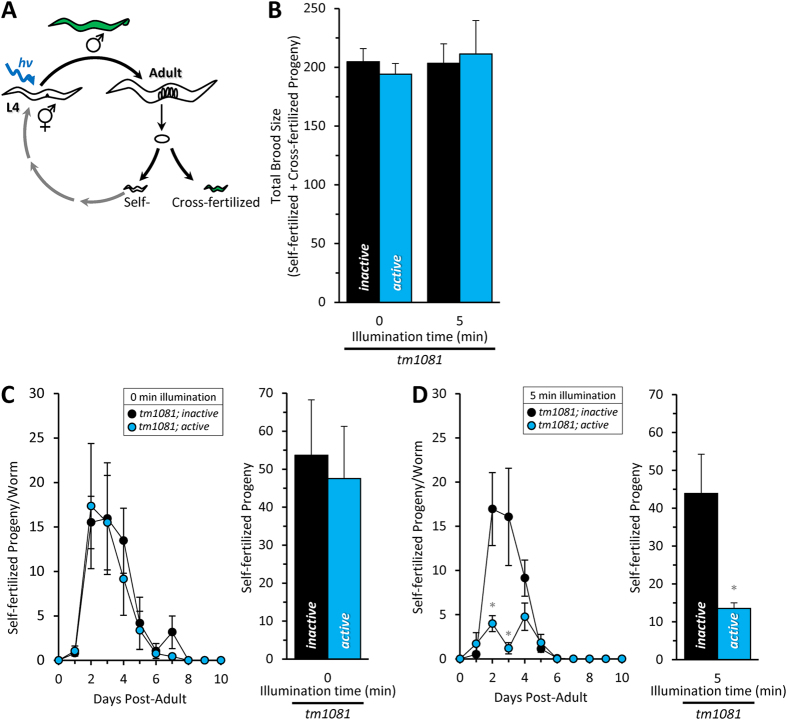
Mating restores CALI-induced decrease in brood size.(A) Schematic of C. elegans life cycle, light exposure and mating. Staged L4 worms were illuminated (day 0) for the indicated time and placed individually onto NGM plates seeded with minimal OP50 (i.e. a mating plate), with males containing an integrated fluorescent transgene. Worms were moved daily to fresh plates over the course of 10 days. Each plate was then scored for self-fertilized (non-fluorescent) and cross-fertilized (fluorescent) progeny. (B) The total brood size is the sum of self-fertilized and cross-fertilized progeny over the 10 day period. Mating did not cause a significant increase in the total brood size in the absence of light (unmated values presented in Fig. 4B; adjusted P > 0.05, Tukey multiple comparisons test), suggesting that sperm are not the limiting factor in the light-independent brood size reduction. (C) The number of self-fertilized progeny in mated tm1081; inactive was no different than in tm1081; active worms in the absence of light (p = 0.76 unpaired 2 tailed t-test), suggesting that the sperm in these two strains are equivalently functional at baseline. (D) However, following 5-min exposure to blue light there was a significant decrease in the self-progeny at day 2 and 3 (adjusted P < 0.0001 vs day-matched inactive counterpart, 2-way ANOVA with Sidak multiple comparisons test) and total self-fertilized progeny (*P = 0.02 unpaired 2-tailed t test), suggesting that sperm are particularly susceptible to complex II CALI in this model. All data are mean ± SEM. N = 6–8. An “N” is considered an independent trials of 1–5 worms per trial. Alleles are abbreviated as outlined in Fig. 1.